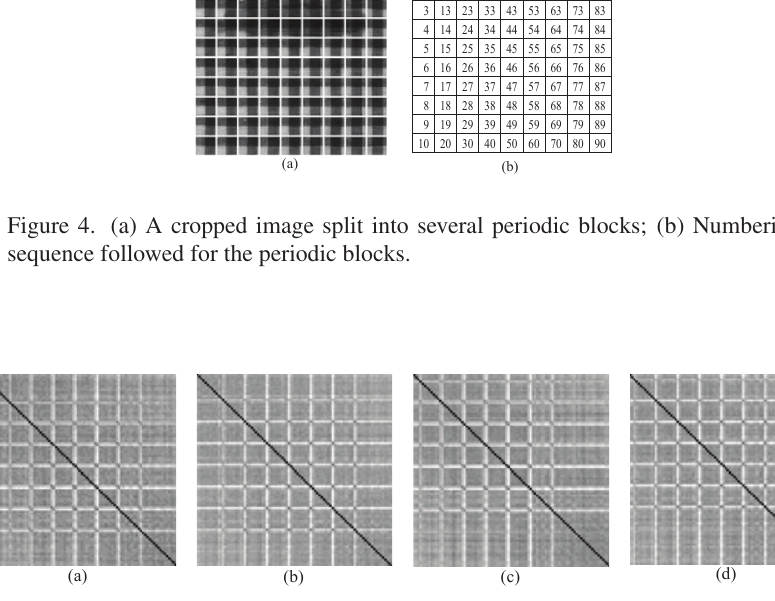
Figure 5. Dissimilarity matrix derived from the chi-square histogram distances of cropped images obtained from (a) top-left (b) bottom-left (c) top-right and (d) bottom-right corners of the test image shown in